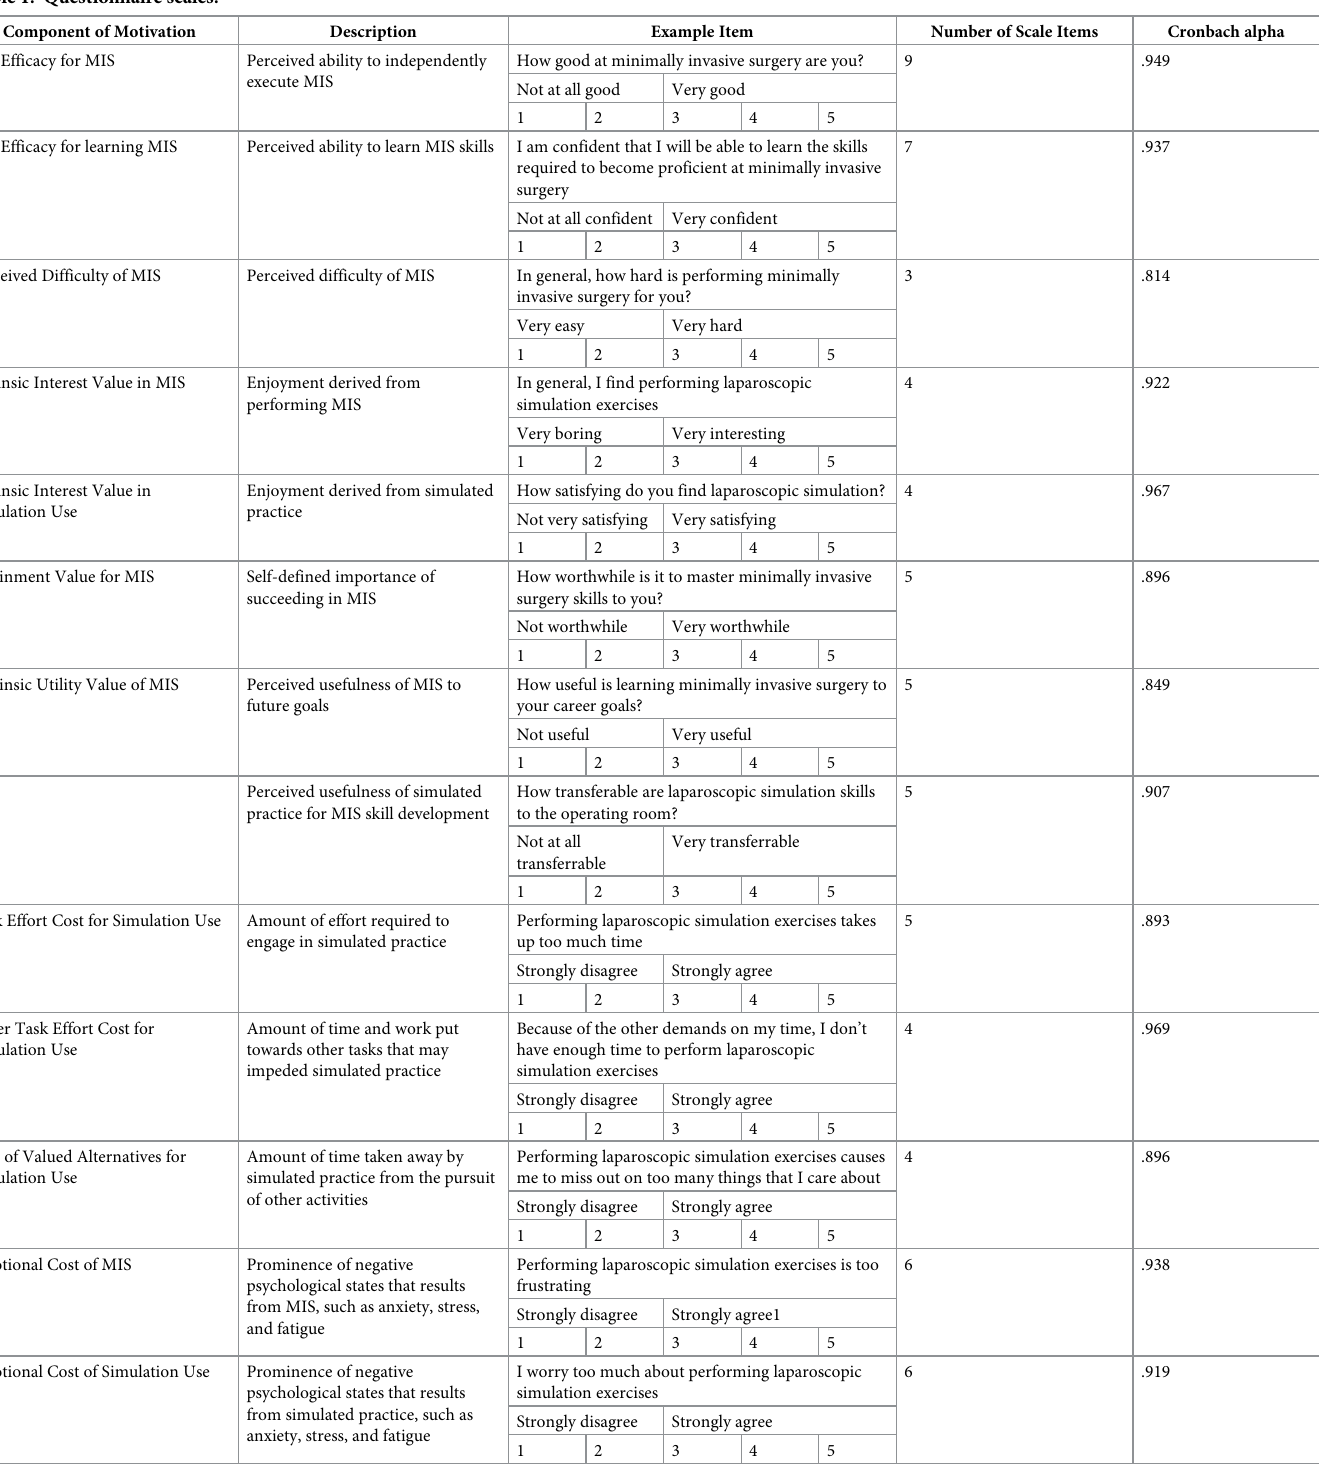
Table 1. Questionnaire